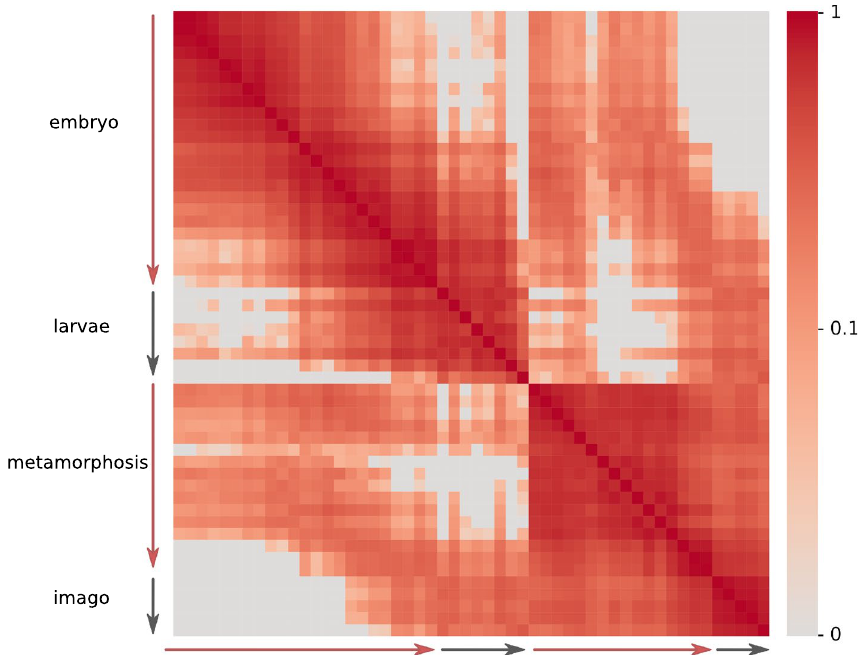
Figure 1. Pairwise correlation coefficient heatmap for D. melanogaster developmental stages. Sequential stages of development are shown on both axes with arrows indicating the four major stages. The color of each cell reflects the Spearman correlation coefficient of gene expression profiles for the respective developmental stages: the brighter is the cell, the higher is the correlation coefficient. The heatmap is symmetric with respect to the diagonal. The expression data are from 13